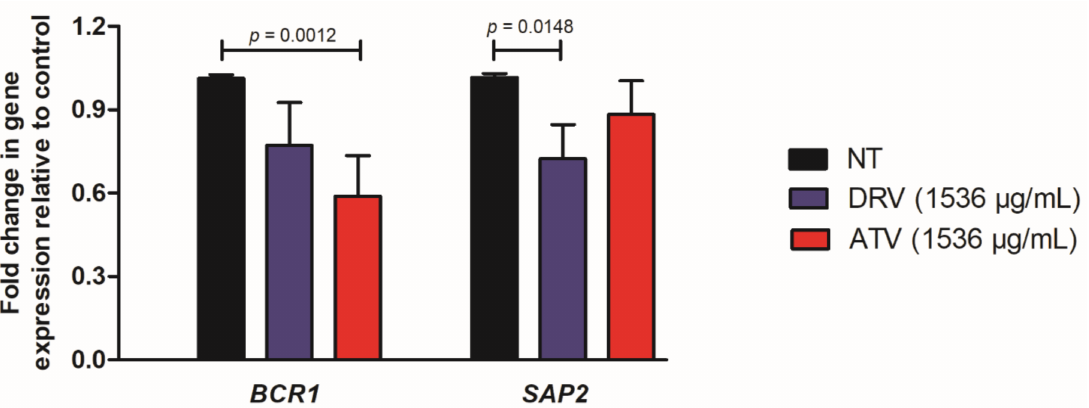
Figure 3. Relative expression of C. albicans genes. Relative quantification of BCR1 and SAP2 genes for Ca70 biofilms non-treated (NT) and treated with darunavir (DRV) and atazanavir (ATV). Normaliza- tion was performed using the RIP1 gene. DRV and ATV treatments were compared with NT using the student’s t -test ( p <